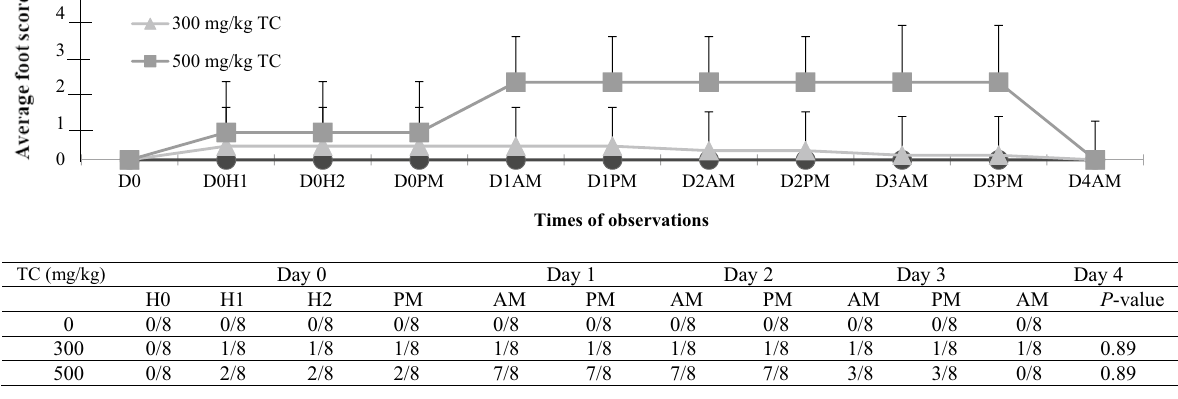
Figure 3. The averaged foot/leg scores (means ± SD; upper panel) and number of mice with scores of > 0 (lower panel) in controls and TC treated mice. D and H: day and hour post-injection. Scoring system: 0 = normal; 1 = closed digits but walked well; 2 = closed digits, no grip; 3 = closed digits, no grip, dragging leg, foot flipped.